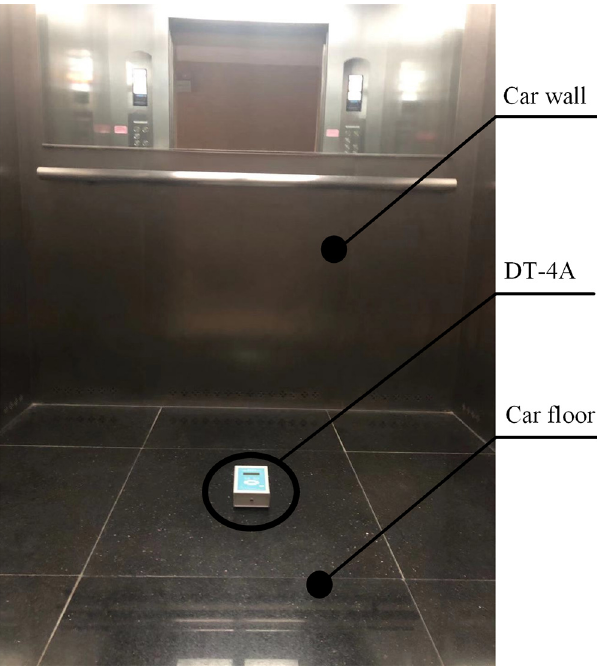
Fig. 7. The measuring points of the car.